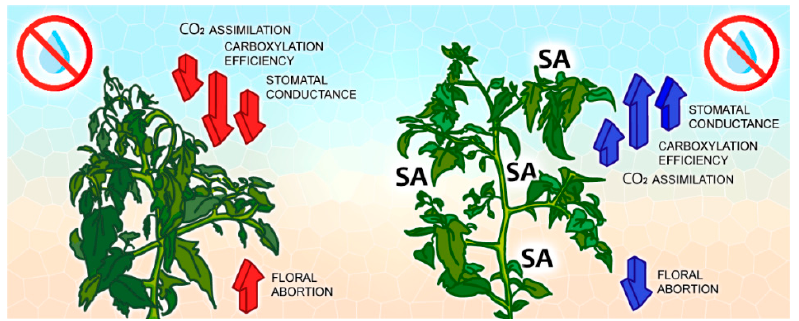
Figure 6. Graphical abstract of Foliar application of salicylic acid to mitigate water stress in tomato.